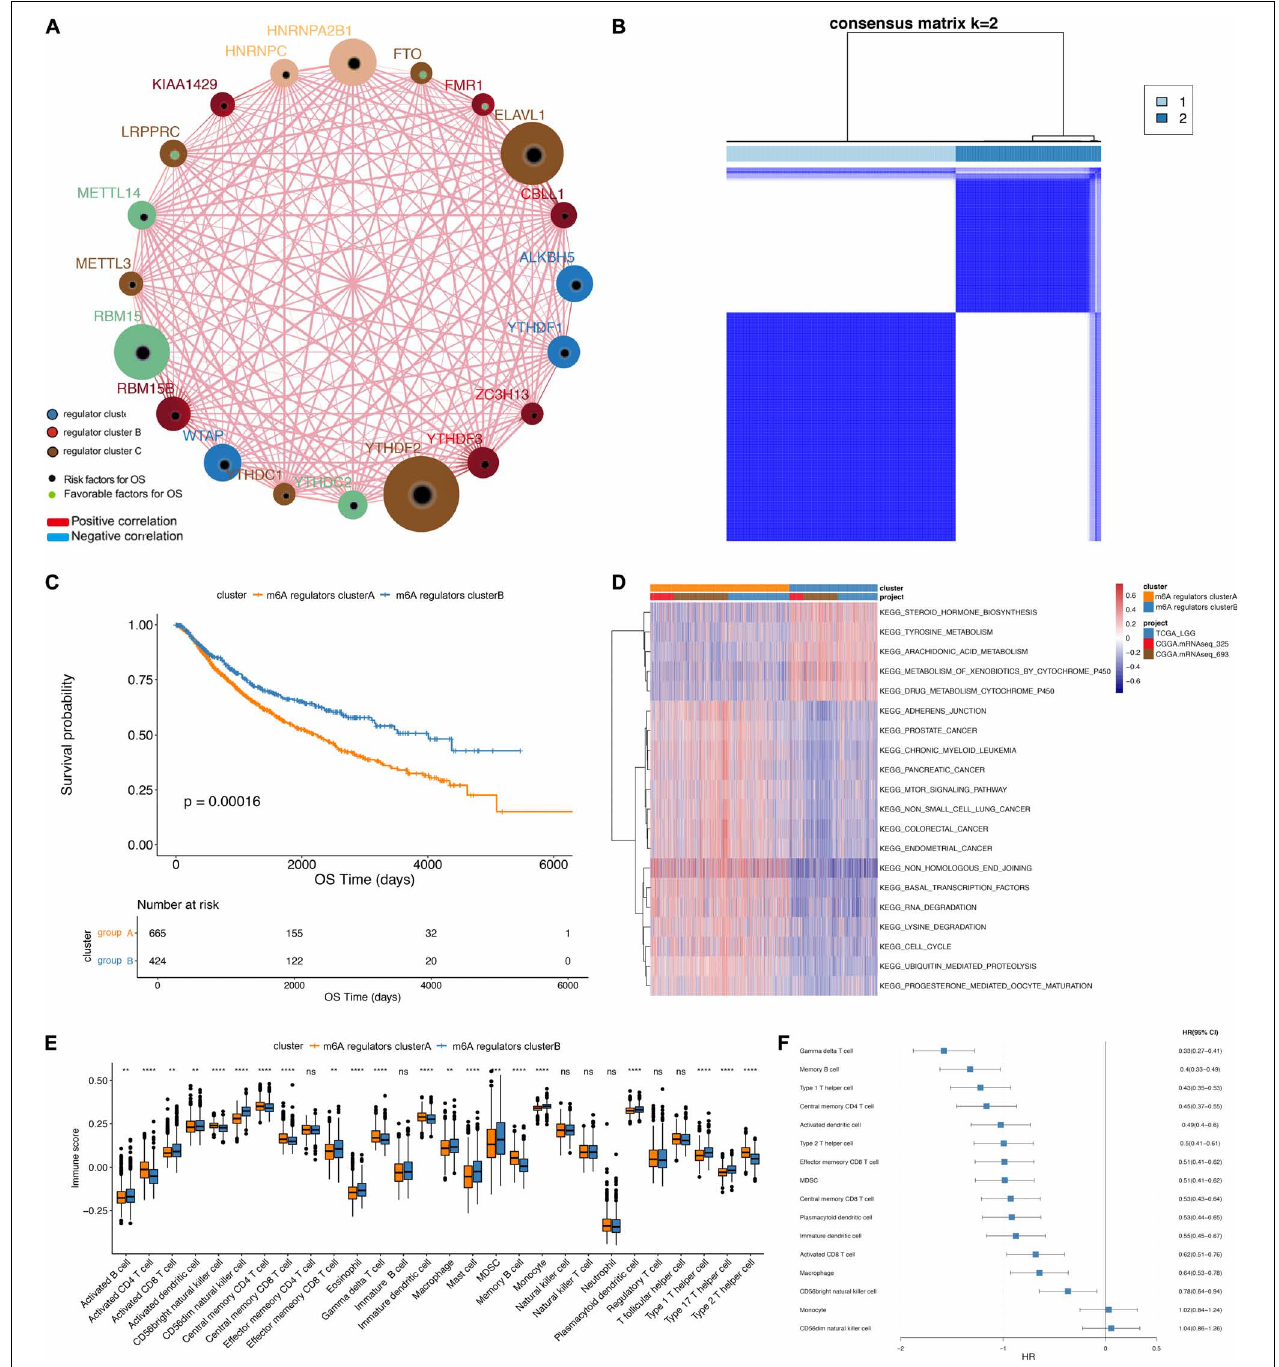
FIGURE 2 | Unsupervised clustering of m6A genes in low-grade glioma samples. (A) Interaction between m6A genes. The size of the circle indicates the impact of each gene on survival prediction, and the larger the expression, the more relevant the prognosis. In the circle the green dots in the circle indicate prognostic protective factors, and the black dots in the circle indicate prognostic risk factors. The lines connecting genes show their interactions. The negative correlations are marked in blue and positive correlations in red. Gene clusters ABC are marked in blue, respectively, color, red and brown. (B) Consistent clustering of m6A genes. (C) Kaplan-Meier curve showing significant survival differences in two m6A regulators clusters. (D) GSVA enrichment analysis, showing the biological pathways with different m6A regulators clusters Activation state. Heat map is used to visualize these biological processes, red means activation, blue means inhibition. (E) The distribution of immune infiltration of 22 immune cells in 2 m6A regulators clusters (** p < 0.05, **** p < 0.001). (F) Differential cell prognosis analysis.